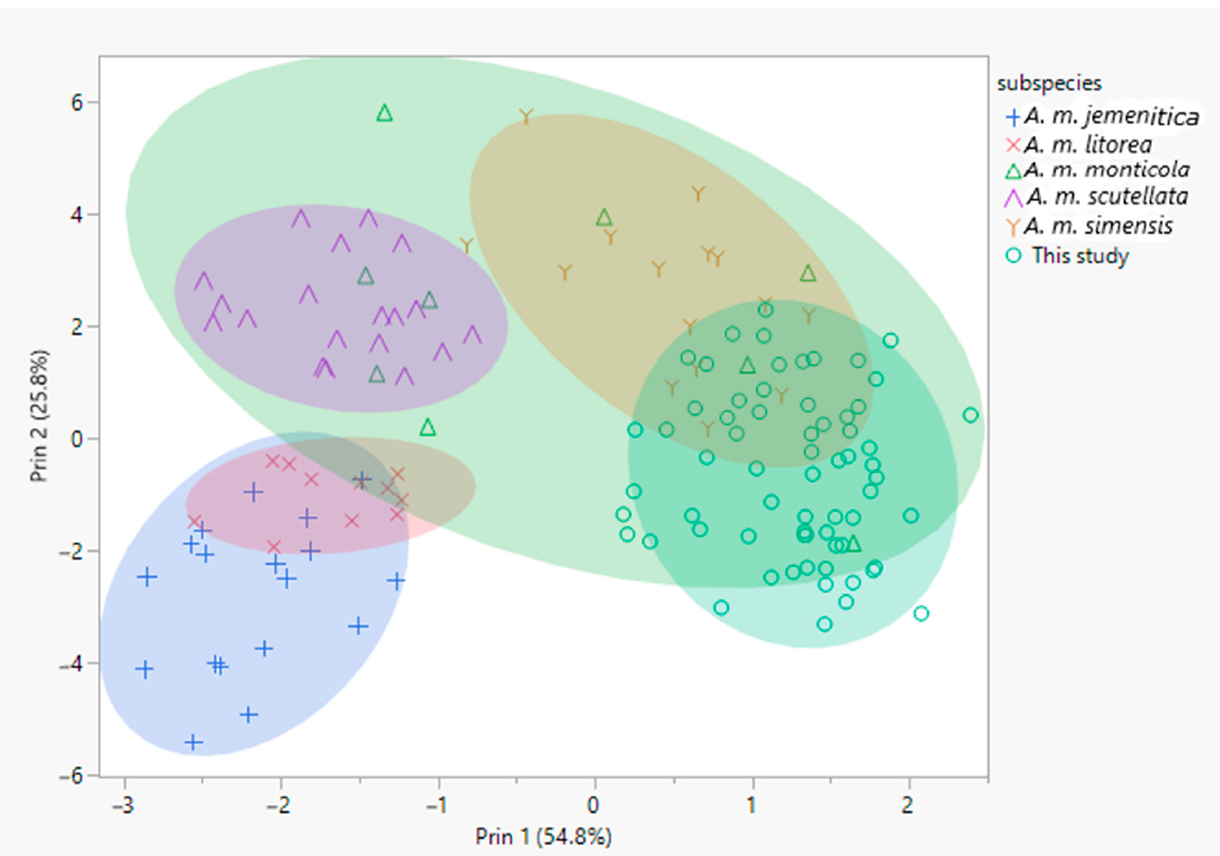
Figure 1. Scatter plot of principal component scores of this study’s samples and reference subspecies of A. m. scutellata, A. m. jemenitica, A. m. simensis, A. m. litorea and A. m. monticola . Scores were generated from nine morphometric characteristics: forewing length, forewing width, femur, tibia, metatarsal length, metatarsal width, total length of hind leg, cubital vein distance a and cubital vein distance b.